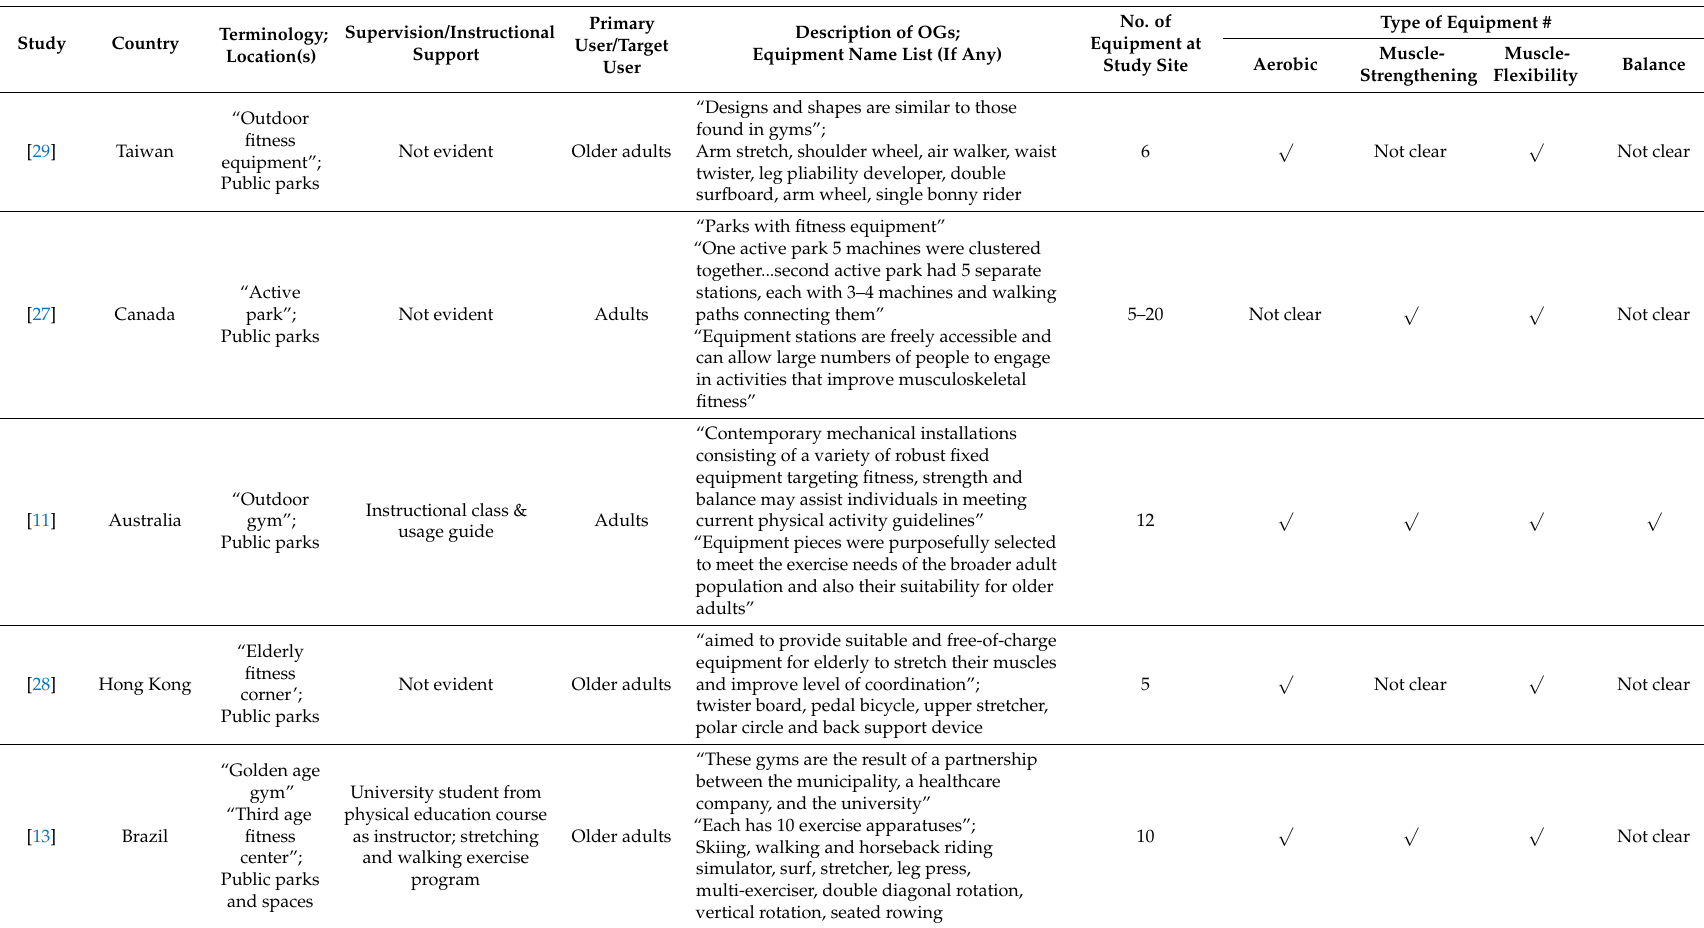
Table 2. Characteristics of outdoor gyms of the included